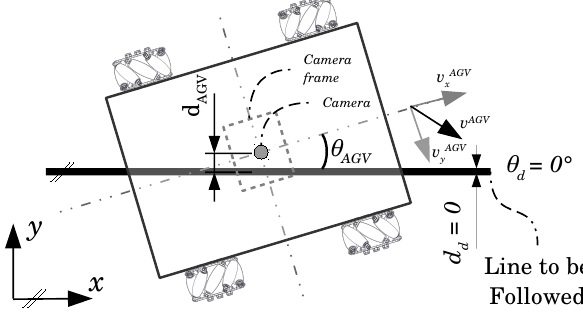
Figure 4. Line following problem formulation.